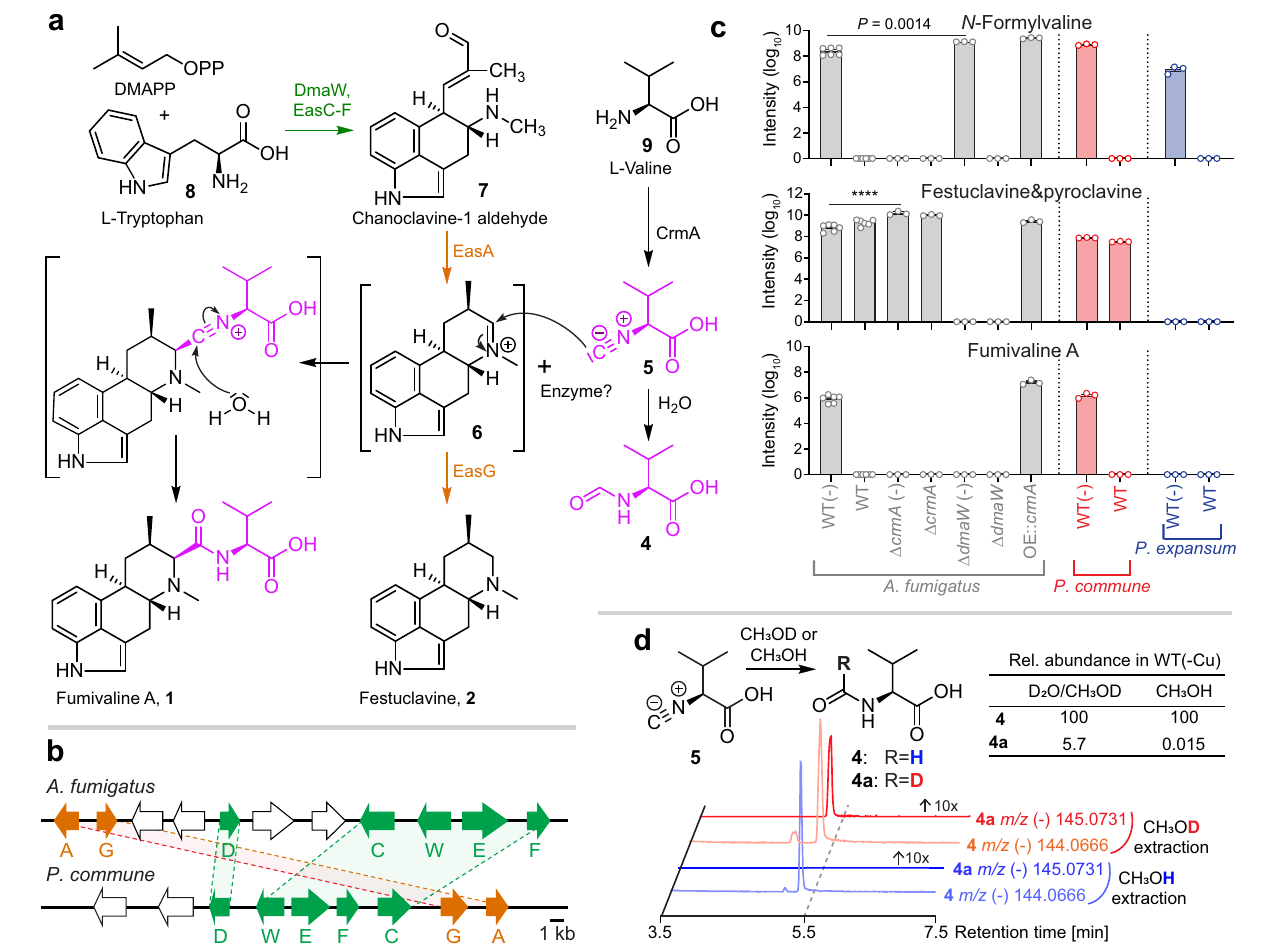
Fig.2|ComparisonoffumivalineBGCsandergotalkaloidsproduction.a Ergot alkaloid biosynthesis pathways in A. fumigatus and P. commune . L -Tryptophan ( 8 ) anddimethylallylpyrophosphateareconvertedintochanoclavine-1aldehyde( 7 )by DmaWandEasC-F,whichisthenconvertedintofestuclavine( 2 )byEasAandEasGin A. fumigatus and P. commune . Valine ( 9 ) is converted into valine isocyanide ( 5 ) by CrmA,whichthenreactswiththeimineintermediateoffestuclavine( 6 ),resultingin formation of the amide bond in fumivaline A following hydration. In addition, hydration of valine isocyanide ( 5 ) produces N -formylvaline ( 4 ). b Comparison of crm BGCs of A. fumigatus and P. commune . Homologous genes are marked using the same colors as in a . A and C-G represent easA and easC-G respectively. W